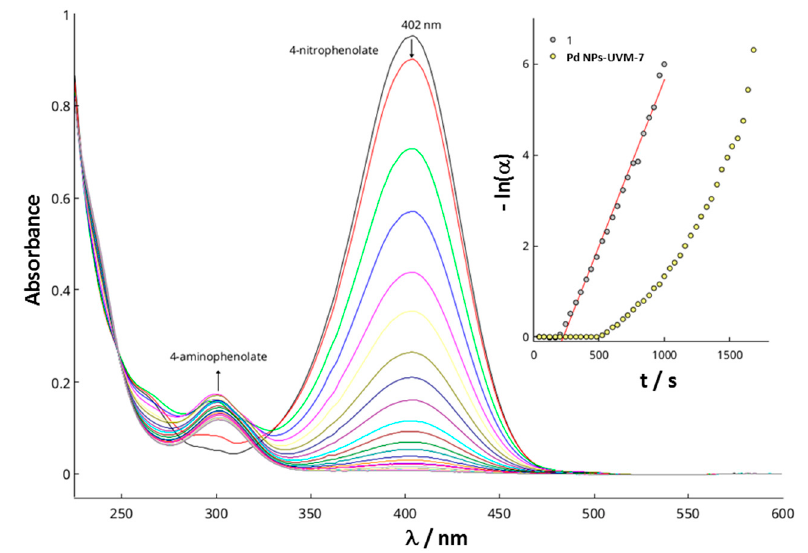
Figure 6. Variation of absorbance during the reduction at room temperature of 4-nitrophenolate with (Et 4 N)BH 4 catalyzed by material Pd NPs-UVM-7/PDA- 1 . Inset : Plot of –ln( α ) vs . time for materials Pd NPs-UVM-7/PDA- 1 and Pd NPs-UVM-7. Pd NPs-UVM-7/PDA- 1 shows pseudo-first-order kinetics ( k = 7.3 × 10 − 3 s − 1 ), in contrast with Pd NPs-UVM-7. Initial composition (both systems): [NO 2 PhO − ] = 5.02 × 10 − 5 M; [(Et 4 N)BH 4 ] = 2.0 × 10 − 2 M; [Pd] = 6.3 × 10 − 8 M. Reaction medium: acetonitrile: water 1:1 v/v.